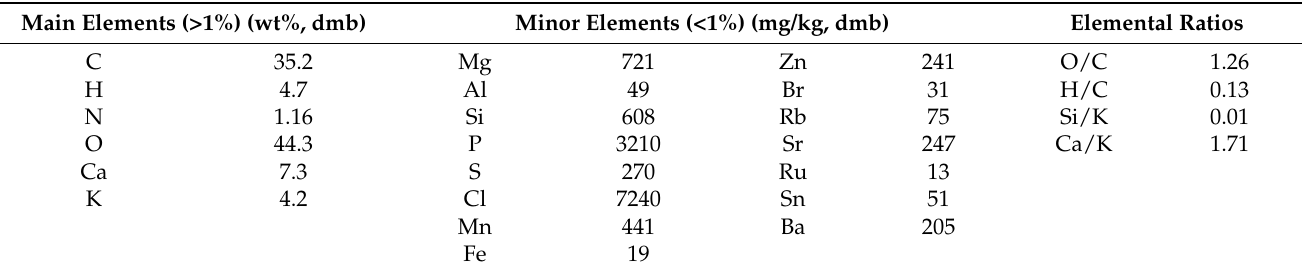
Table 3. Elemental analysis of prickly-pear